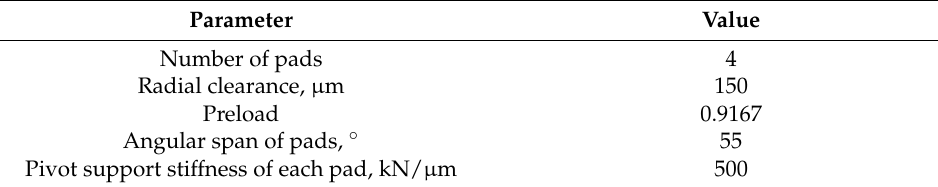
Table 4. Design parameters of the 4-tilting-pad